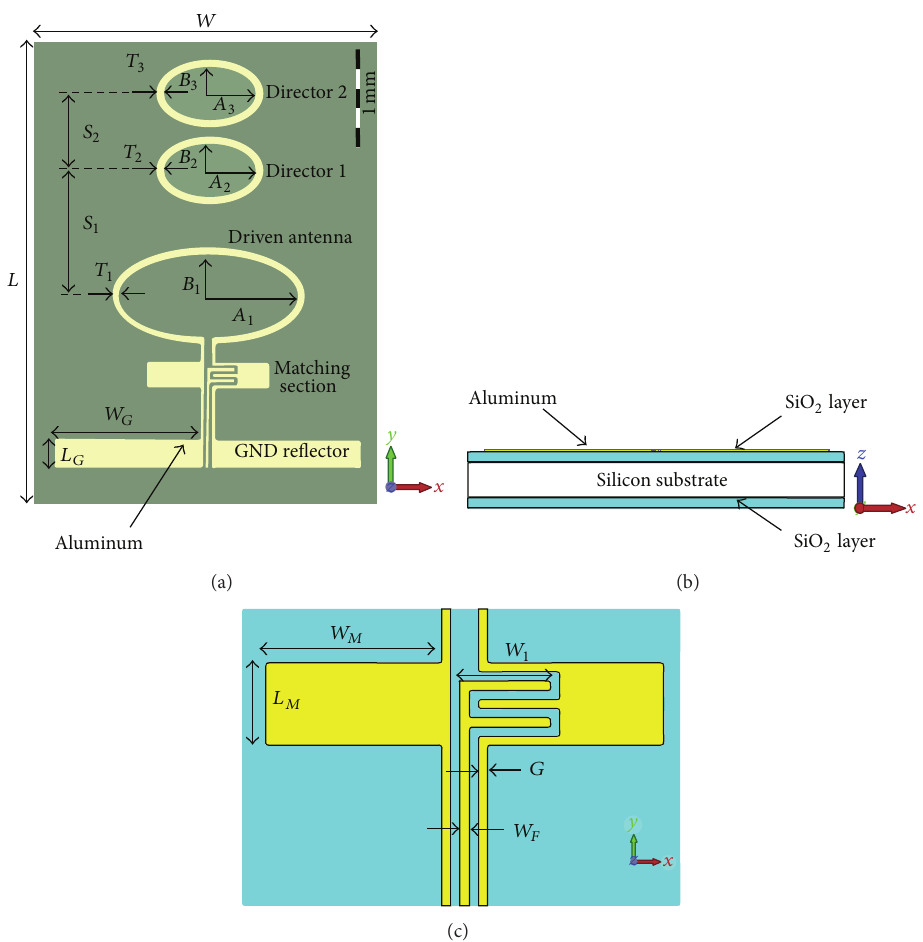
Figure 1: Geometrical configuration and photograph of the fabricated Quasi-Yagi loop antenna prototype I: (a) top view, (b) side view, and (c) detailed view for matching section and CPW